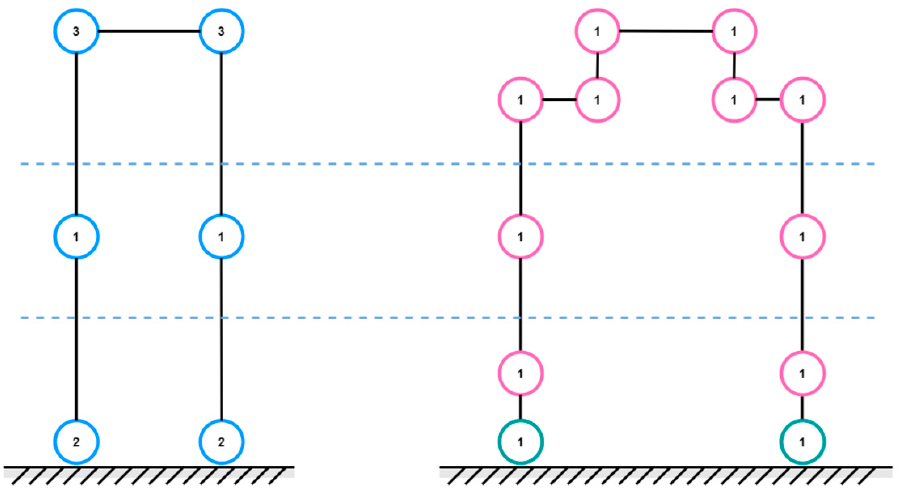
Figure 4. Robot graph based on robot analysis ( left ), robot graph adapted for robot construction ( right ).